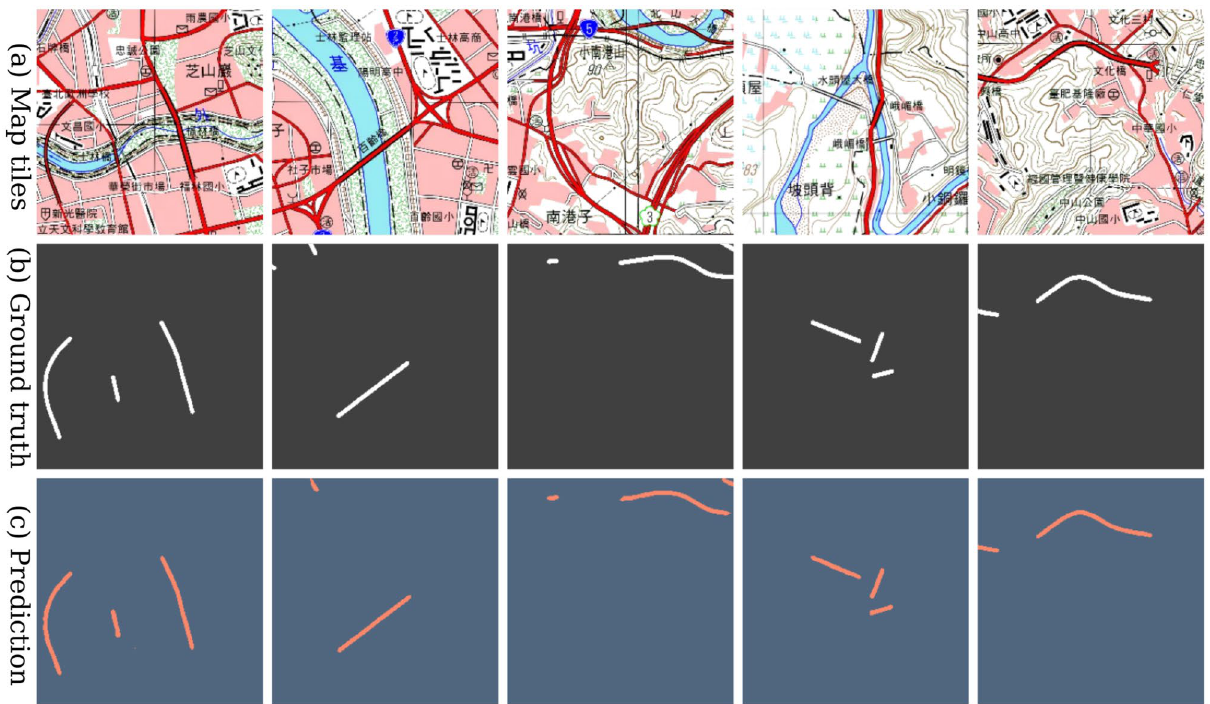
Figure 7. The results made by the U-Net model trained with fully labeled data of the contemporary dataset. ( a ) The contemporary map tiles, ( b ) The groundtruth of bridges symbols, and ( c ) The predictions of bridges on the map tiles. The model predicts almost every bridge symbol on most map tiles successfully. † The maps in this figure are provided by Taiwan Historical Maps System (https:// gis. sinica. edu. tw/ tiles erver/) with